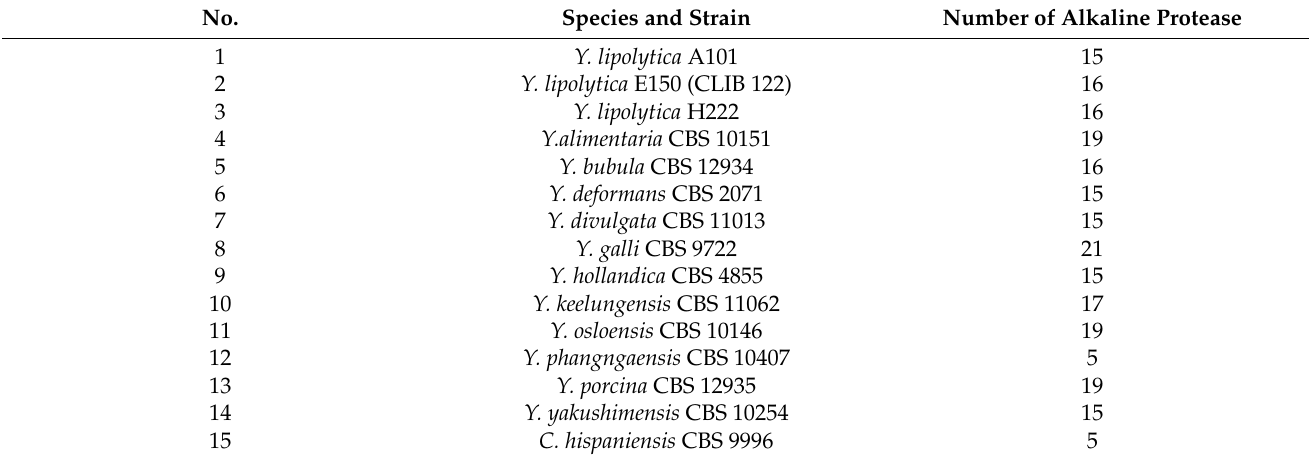
Table 1. Number of alkaline proteases identified in the genomes of Yarrowia clade species. No. Species and Strain Number of Alkaline